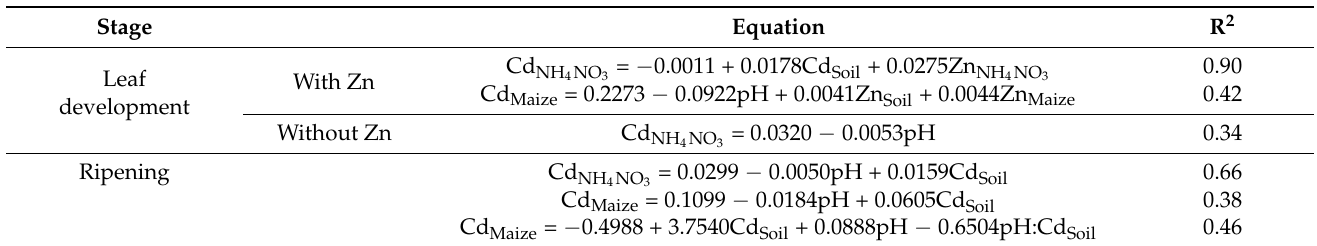
Table 5. Linear regressions for the exchangeable Cd fraction in soil and the total Cd concentration in silage maize. Stage Equation R 2 Leaf development